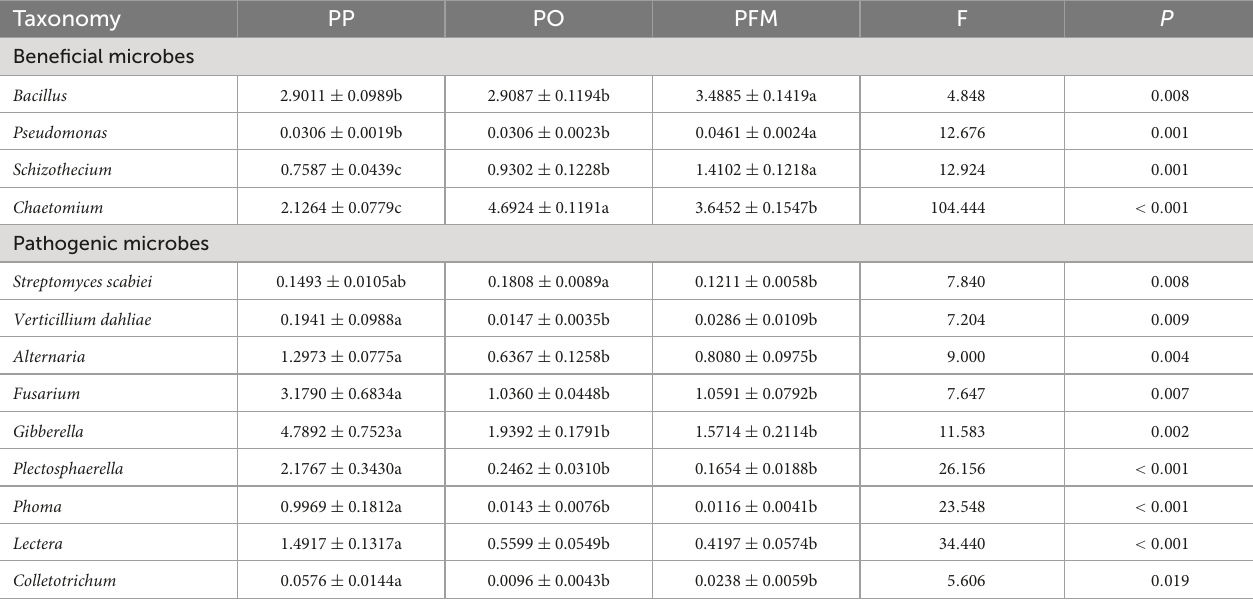
TABLE 2 Relative abundance (%) of beneficial and pathogenic microbes in different crop rotation systems. Taxonomy